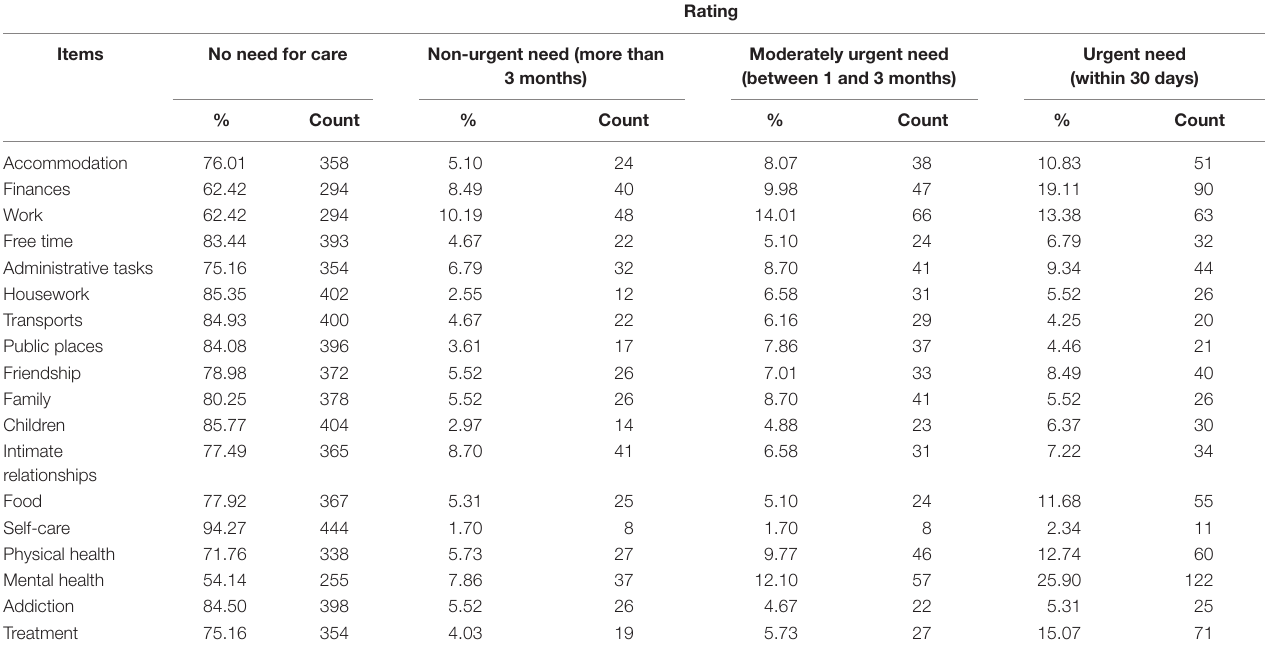
TaBle 2 | Univariate proportions and frequencies for need for care ( N = 471).